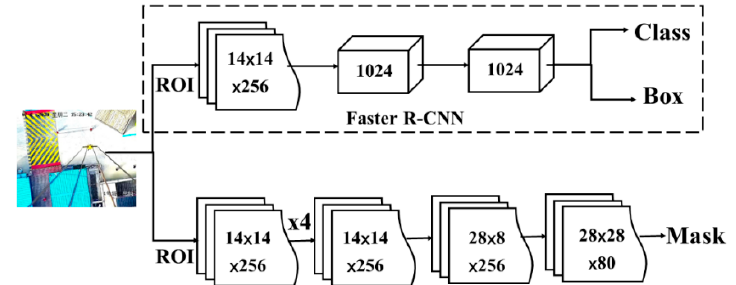
Figure 4. The diagram of the Mask R-CNN identification process.